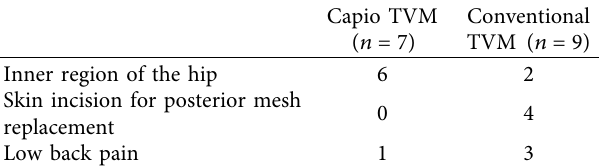
Table 4: Location of most intense pain